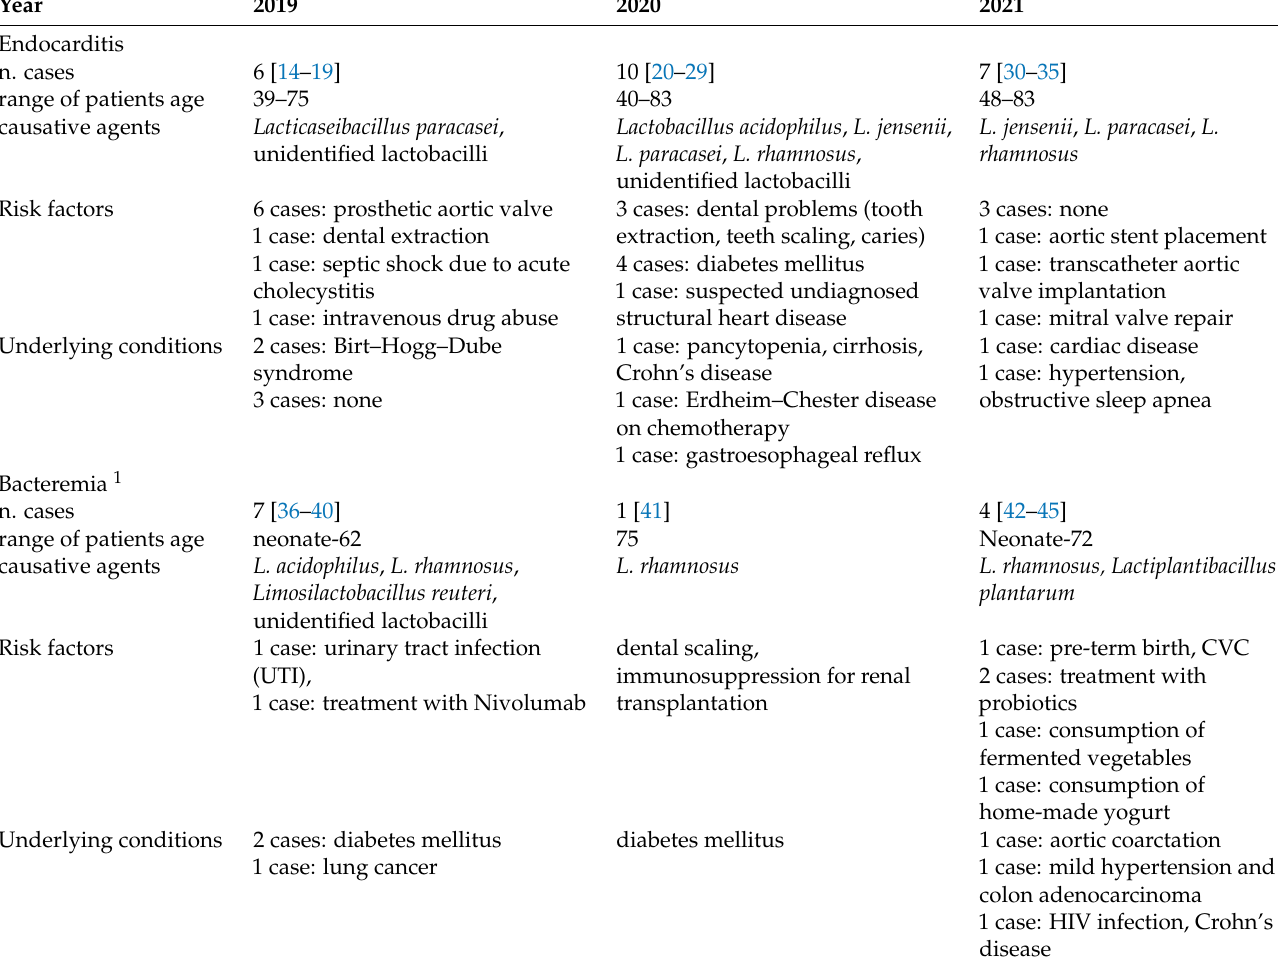
Table 1. Number of case reports per type of infection caused by lactobacilli each year since 2019, with age range of patients, underlying conditions, and species identity of the etiological agents. The number of cases per risk factors and underlying condition are reported separately, though in some instances different risk factors and underlying conditions co-occurred in the same